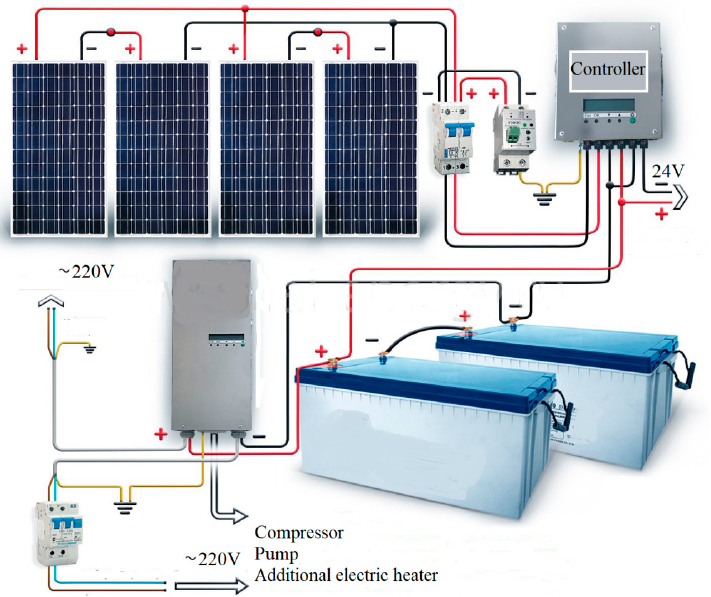
Figure 3. Connection diagram of photovoltaic panels on the heat pump units.